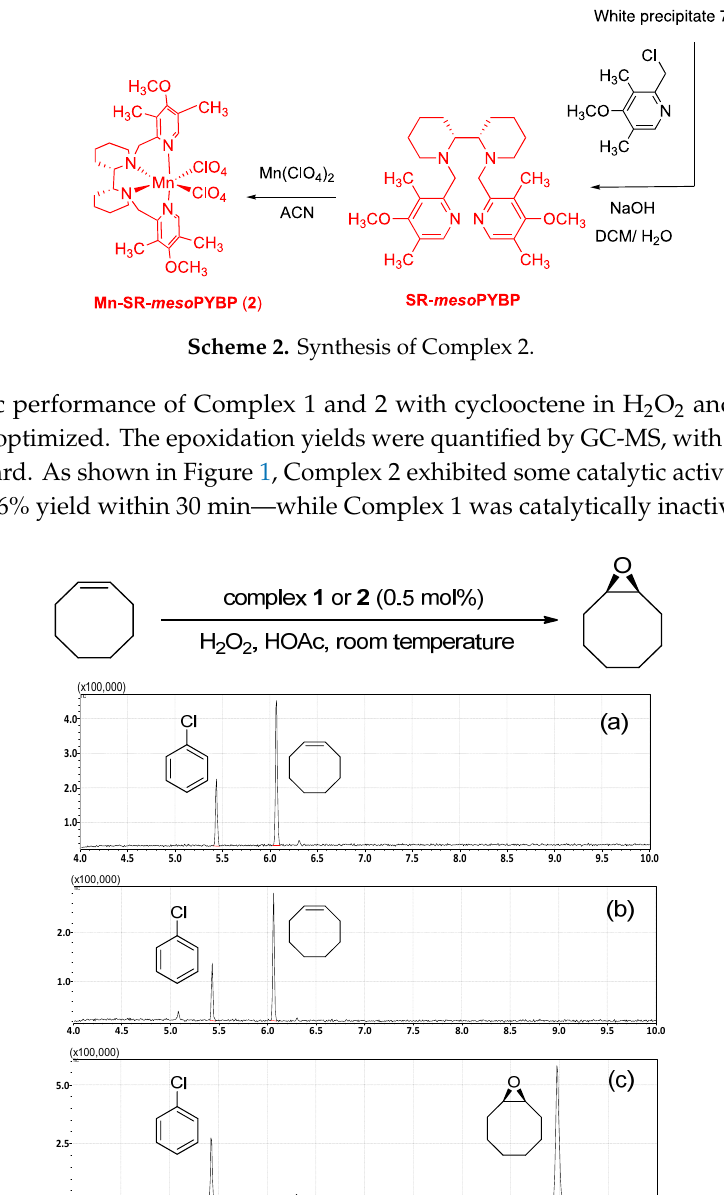
Figure 1. Catalytic performance of olefin epoxidation: ( a ) no catalyst, ( b ) manganese meso PYBP and ( c ) SR- meso PYBP in GC-MS. Reaction conditions: catalyst (0.5 μ mol), cyclooctene (100 μ mol), chlorobenzene internal standard (40 μ mol), H 2 O 2 (30% aqueous solution), HOAc (glacial) in 0.5 mL of acetonitrile, at room temperature. H 2 O 2 was added in five equal portions in the first 4 min. Standard: 5.5 min, cyclooctene: 6 min, cyclooctene oxide: 9